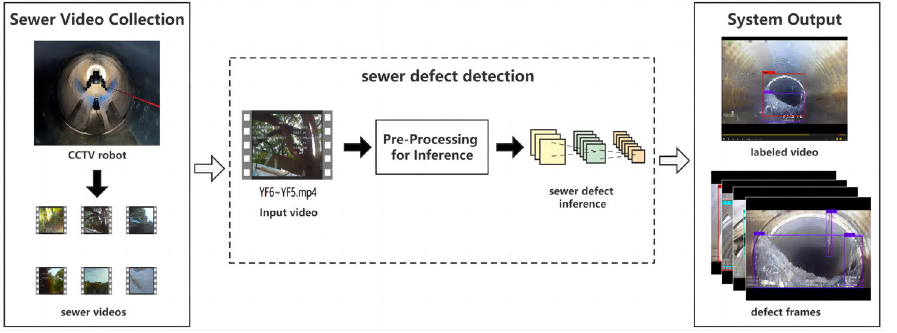
Figure 14. The workflow of sewer defect detection system.